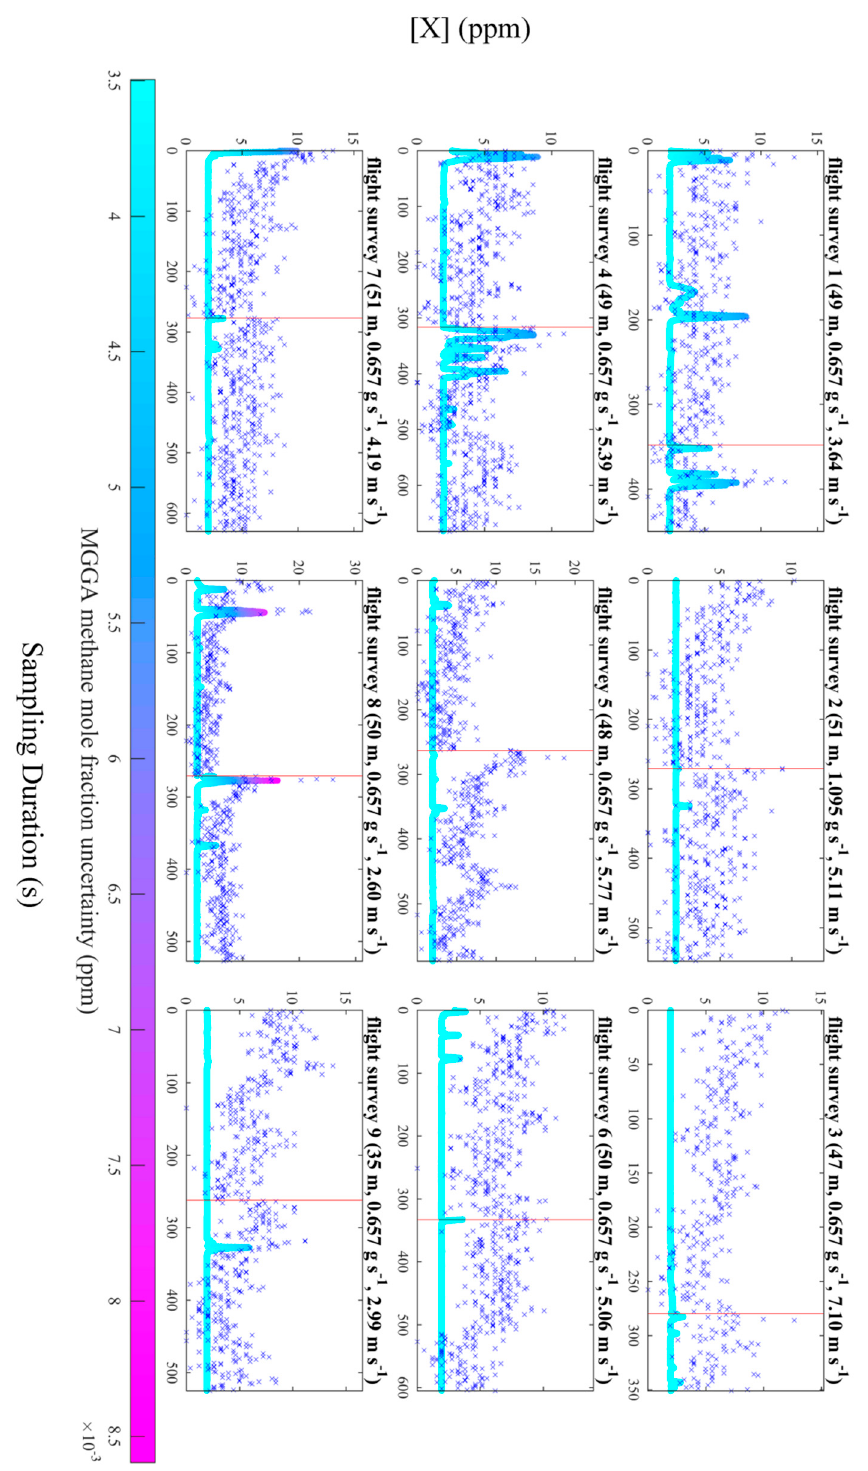
Figure 7. [ X ] for the packaged sensor (blue crosses) and the Micro-portable Greenhouse Gas Analyzer (dots, represented as a solid line) for each flight survey. The colour of each dot represents uncertainty associated with each MGGA measurement. Vertical red lines represent the point at which individual UAV flights are combined.